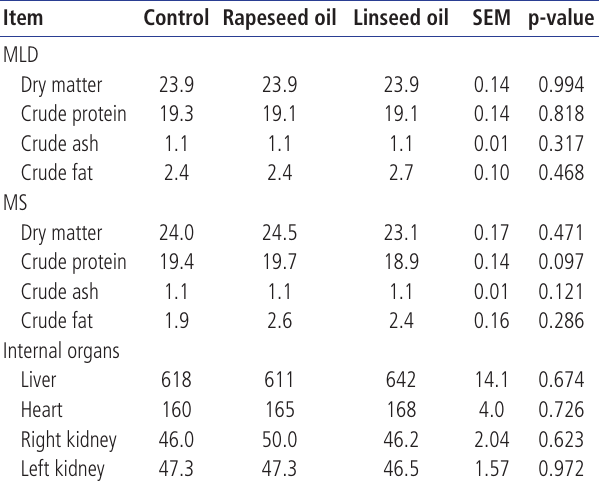
Table 4. Chemical composition of muscles (g/100 g) and internal organs weight (g)